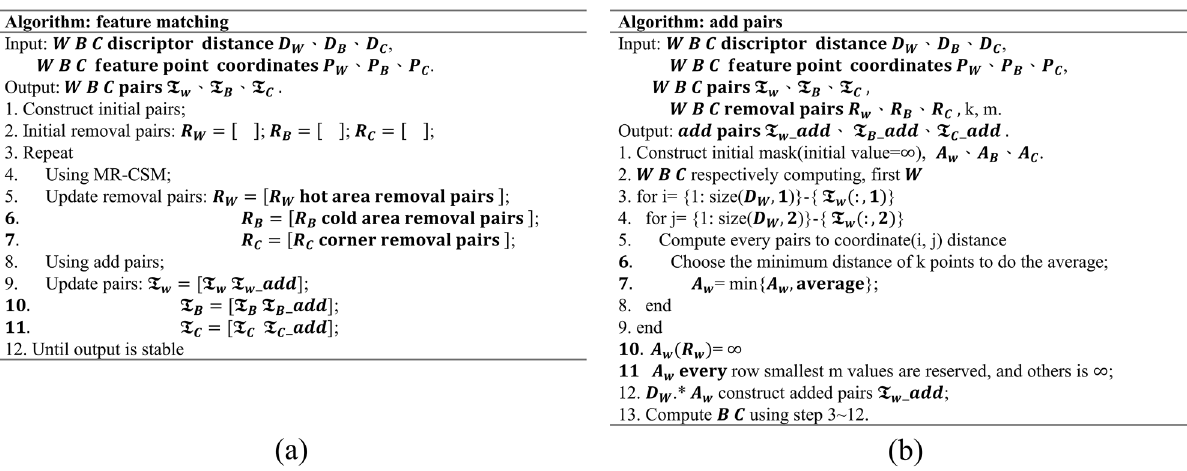
Figure 20. pseudo-code for ( a ) matching and ( b ) the addition of